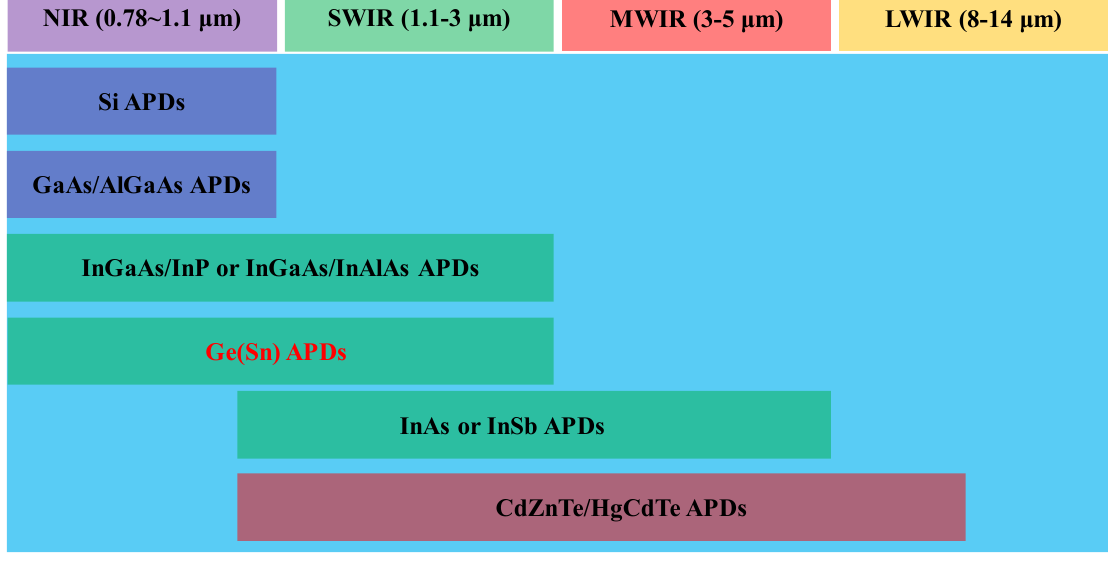
Figure 2. Typical semiconductor APDs versus infrared waveband.